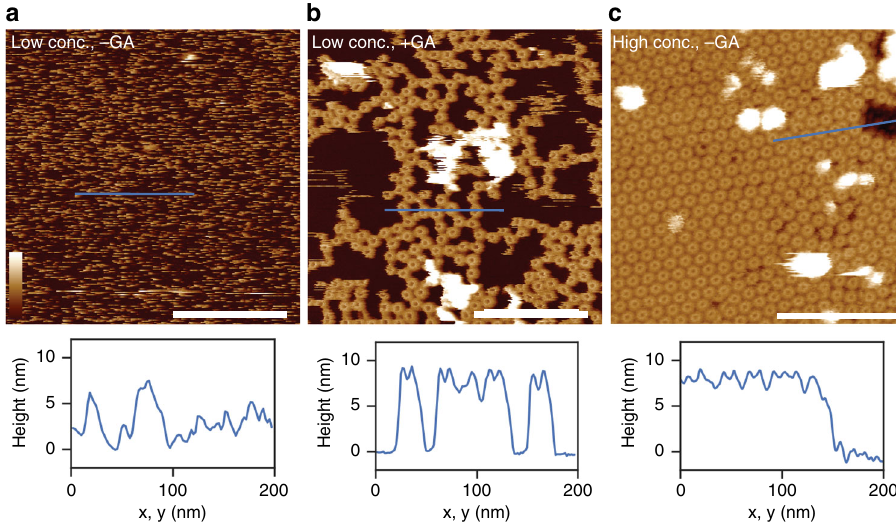
Fig. 3 Atomic force microscopy images of MPEG1 on supported lipid bilayers consisting of E. coli total lipid extract. a Without (-GA) and b with ( + GA) glutaraldehyde fi xation, at neutral pH. c Increasing the concentration of MPEG1 results in a high-density, hexagonal packing on the supported bilayer. The dynamic motion observed in a is therefore reduced, such that the MPEG1 assemblies could be well resolved without glutaraldehyde fi xation. Shown below each AFM images are 1D height pro fi les extracted from selected regions (blue lines) where both membrane and MPEG1 prepores are observed. When packed in dense hexagonal lattice, the MPEG1 assemblies mostly occlude the membrane from the AFM probe, resulting in a smaller height variation (until a region of bare membrane is encountered). Scale bar: 200 nm. Colour (height) scale: 16